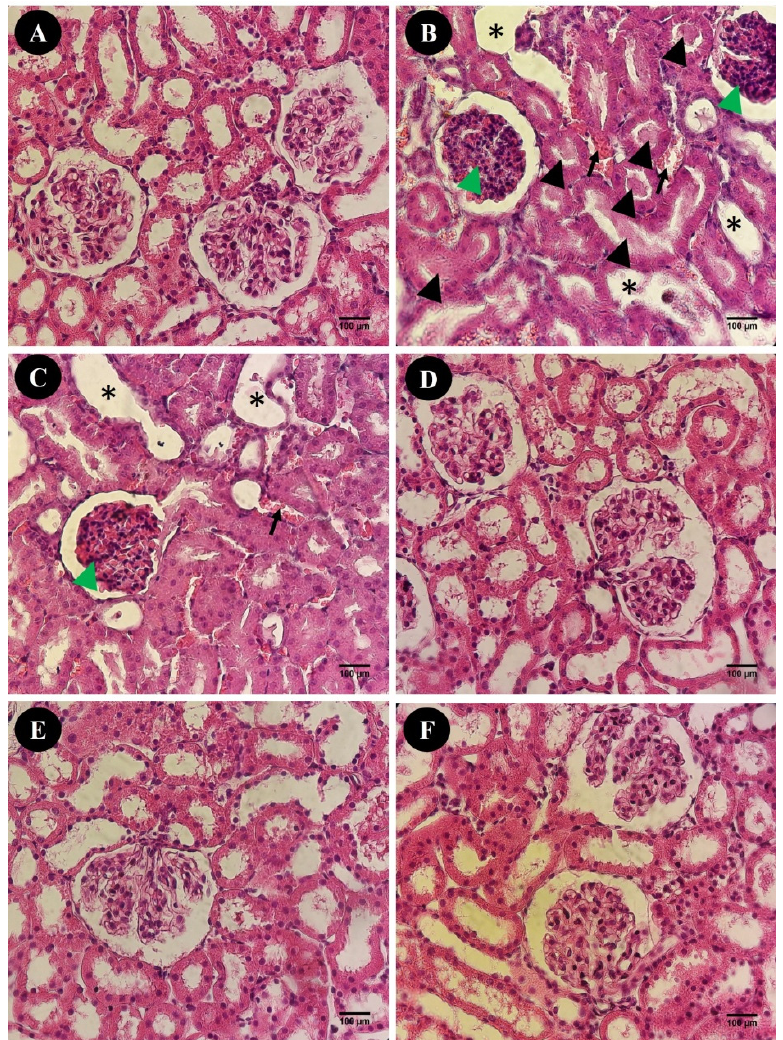
Figure 5. Photomicrographs of renal histology stained with Hematoxylin-Eosin (H&E) assay in different rat groups ( n = 8) at the end of interventions. ( A ): normal renal structure in control group; ( B ): abnormal features in the kidneys of rats subjected to ischemic/reperfusion (I/R) including hemorrhage (black arrow), tubular vasodilation (asterisk), glomerular atrophy (green arrowhead) and intratubular casts (black arrowhead); ( C ): some degree of renal damages including hemorrhage (black arrow), tubular vasodilation (asterisk) and glomerular atrophy (green arrowhead) in spironolactone (SP)-treated ischemic/reperfusion (I/R) group; ( D ): restored normal kidney histological features in nano-encapsulated spironolactone (NESP)-treated I/R group; ( E , F ): normal histology of kidneys in SP- and NESP-treated groups, respectively.